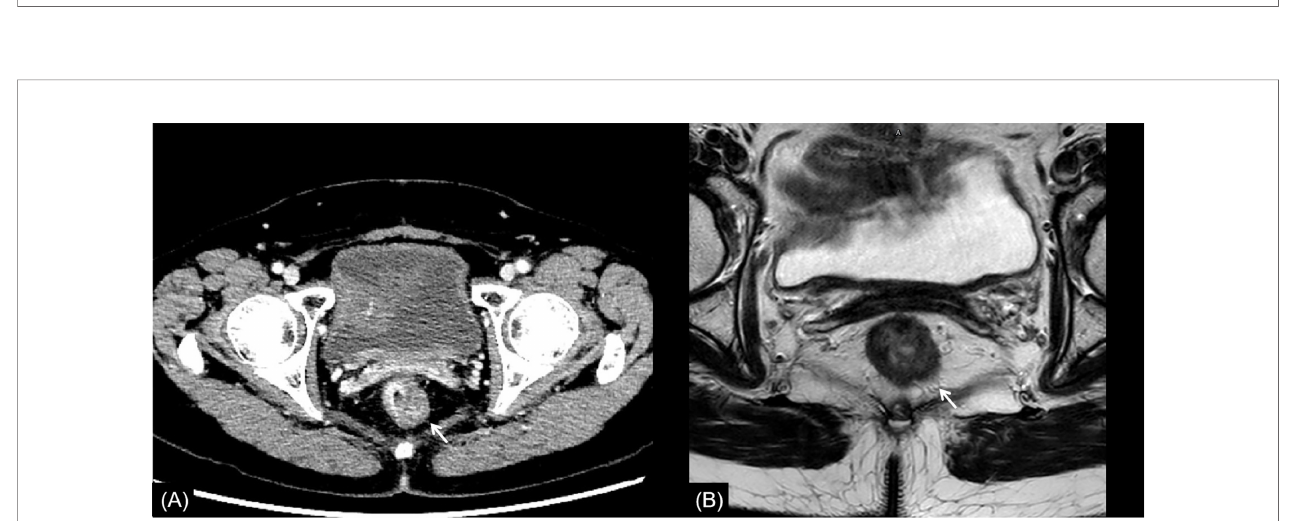
FIGURE 4 | Rectal cancer with ypT2N0. (A) Axial MSCT depicts a heterogeneous enhancing rectal tumor (arrow) with a mild rough outer wall. Over restaged as T3. (B) MRI transverse high-resolution T2WI shows a heterogeneous signal mass involving left rear mesorectal fascia (arrow). Over restaged as T3. yp: pathological staging after neoadjuvant chemoradiotherapy; T, tumor; N, node; MSCT, multi-slice computed tomography; MRI, magnetic resonance